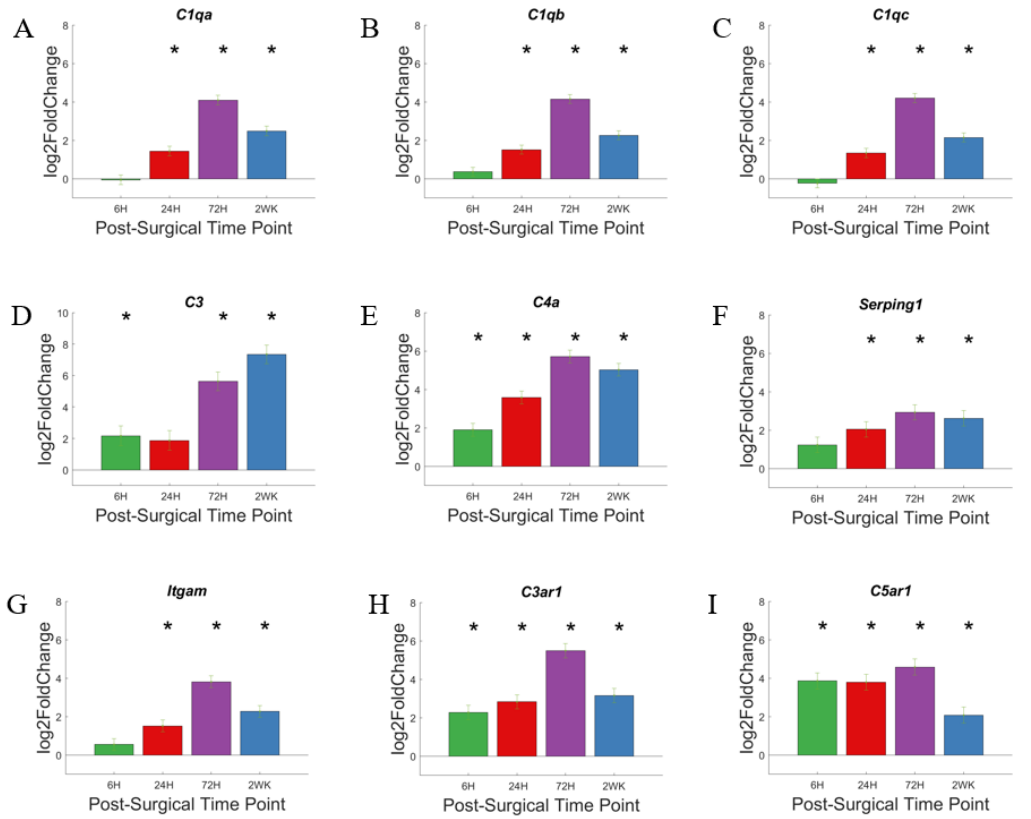
Figure 4. Differential expression of specific genes involved in the complement pathway compared to NSCTR mice: Top differentially expressed genes for the complement pathway displayed as bar graphs of individual genes as a function of time post-surgery ( A – I ). For each time point, gene expression levels are compared to the NSCTR mice. Error bars indicate the standard error of the mean between NSCTR and each time point. Asterisks indicate that P adj < 0.05. Note ( D ), which depicts the upregulation of C3 , has a y-axis log2foldchange scale of −1 to 10, because of its high upregulation. The complement pathway can be initiated via the classical pathway, lectin-binding pathway, or alternative pathway. All three pathways converge on the amplification step of C3 [58,59]. While most of the members of the complement system begin to show less upregulation by 2-weeks post-surgery, C3 continues to show an increase in upregulation of gene expression, increasing with each time point evaluated here. Note that C3 itself can